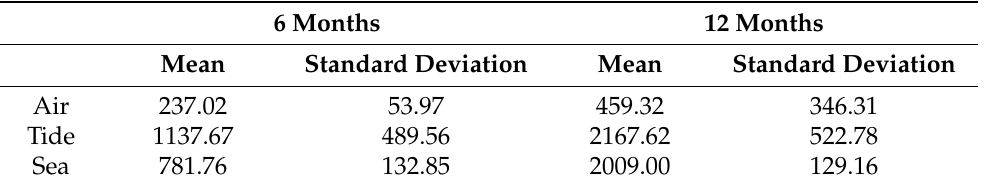
Table 5. Descriptive statistics for corrosion caused by the influence of different